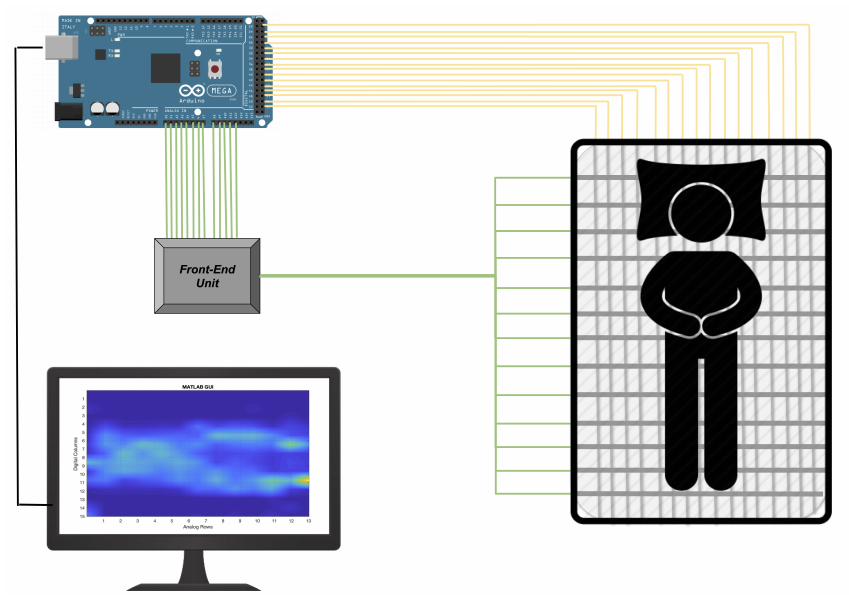
Figure 4. The PML is composed of a 13 × 15 sensing elements structure in which the 15 columns are connected to the digital port of the Arduino Board while the 13 rows are connected to the analog port through the front-end